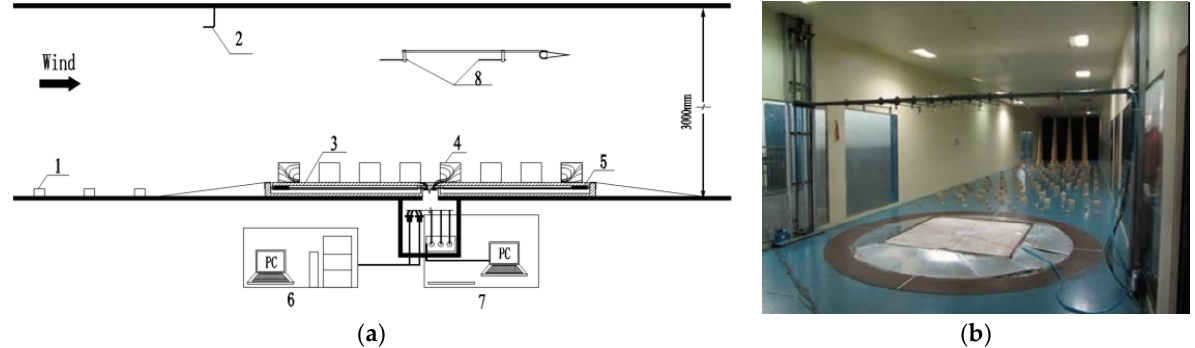
Figure 6. ( a ) Schematic diagram of wind tunnel platform. 1. Terrain roughness elements, 2. Pitot-static tube, 3. Floating device, 4. Pressure module, 5. Force sensor, 6. Pressure scanning valve system, 7. Force sensor system, 8. Hot-wire anemometers. ( b ) Actual setup in the wind tunnel.